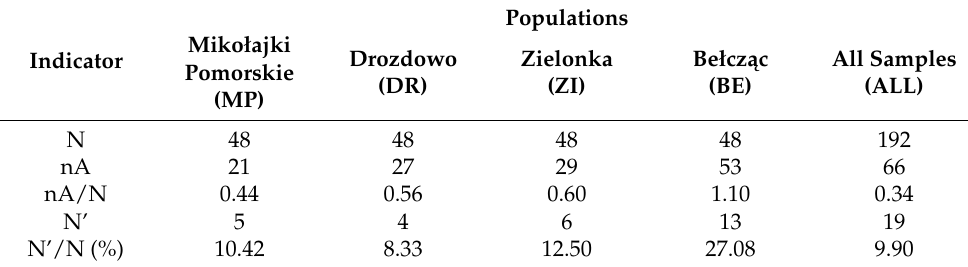
Table 1. Summarized results of the sample selection by Genassemblage 2.2 software. N—number of samples in the input file, nA—number of alleles detected in a given population, nA/N—number of alleles per sample, N’—minimal number of samples required to transfer entire detected allelic diversity to the progeny, N’/N—share (in %) of samples selected by the software in the number of all samples in the input